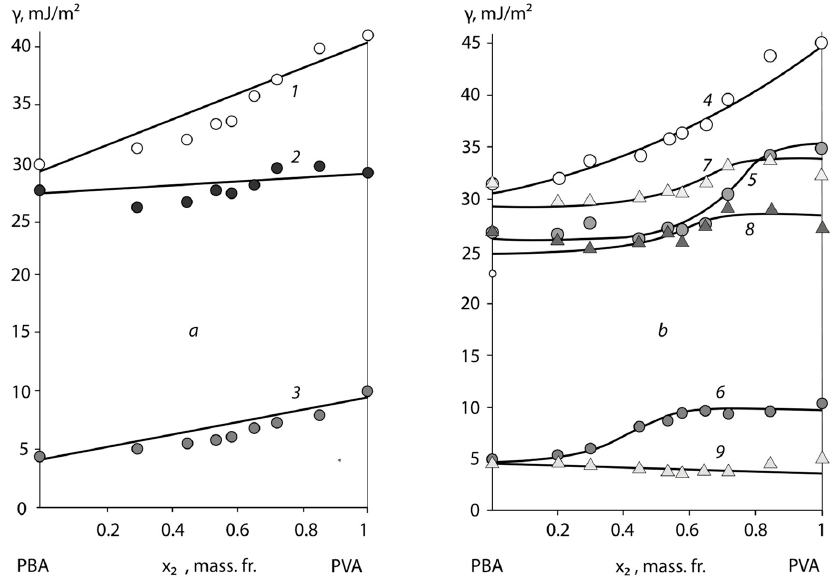
Figure 3. Dependence of the surface energy γ (1, 4, and 7) andits polar γ P (2, 5, and 8)and dispersion components γ D (3, 6, and 9)on the composition of BAC copolymers at 293 ± 1 K. BAC surface is formed on the: ( a ) air—(1, 2, and 3), and ( b ) aluminium—(4, 5, and 6) and PTFE—(7, 8, and 9). Table 3. Critical surface energies of copolymers according to Zisman.